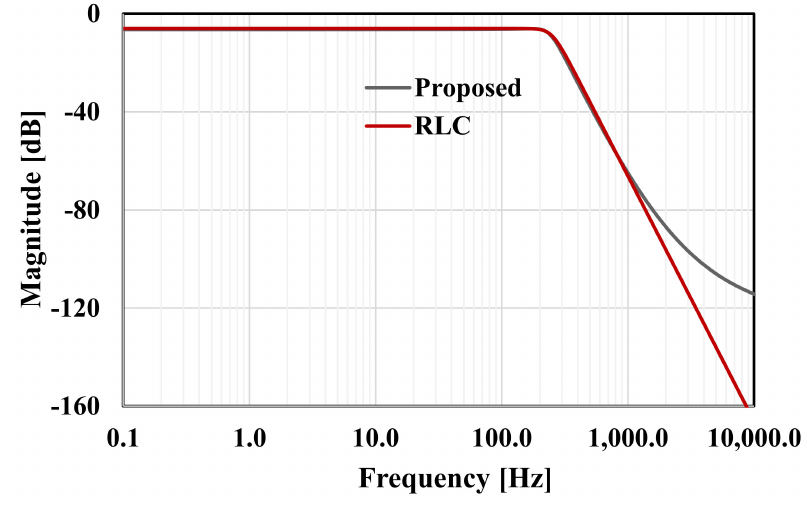
Figure 10. The frequency response of the RLC and the proposed filter.